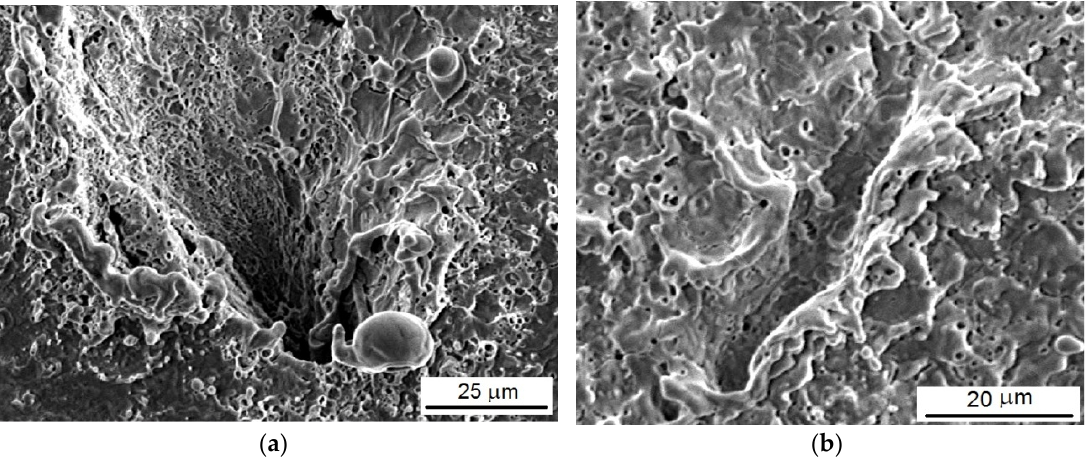
Figure 9. SEM micrographs of the depression ( a ) and ridge ( b ) in bulk W [30].